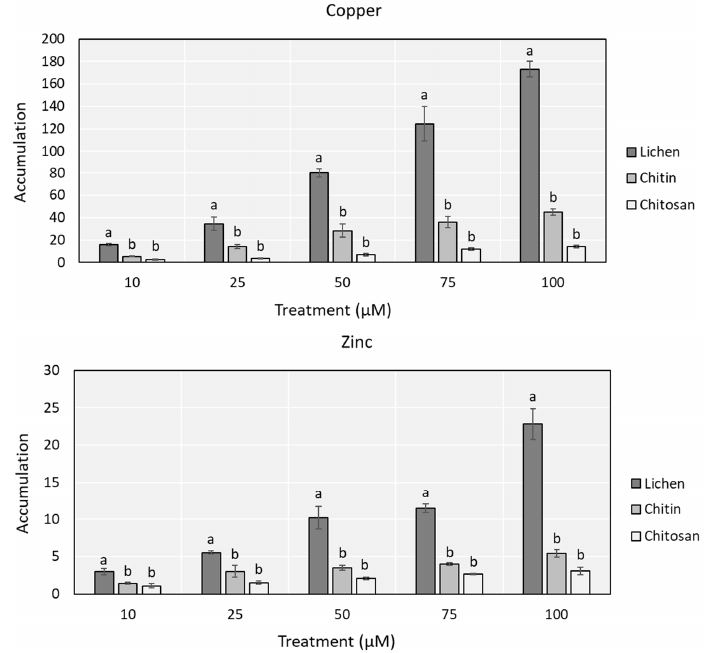
Figure 2. Copper and zinc accumulation (ratio between treated and control value ± SE) in lichen, chitin, and chitosan samples after incubation with Cu (up) and Zn (down) solutions at the concentration of 10, 25, 50, 75, and 100 µM. Different letters (a, b) indicate statistical significant differences between matrices ( p < 0.05).